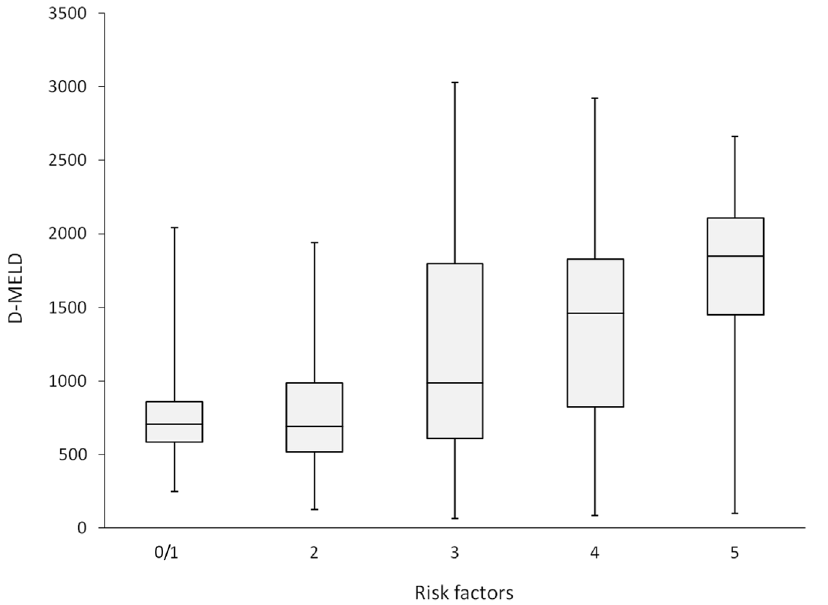
Figure 3. Box-Whisker-Plot depicting D-MELD scores for the number of positive risk factors in the patient collective. While there is an increase of median D-MELD-scores with an increasing number of risk factors, this is no significant correlation.